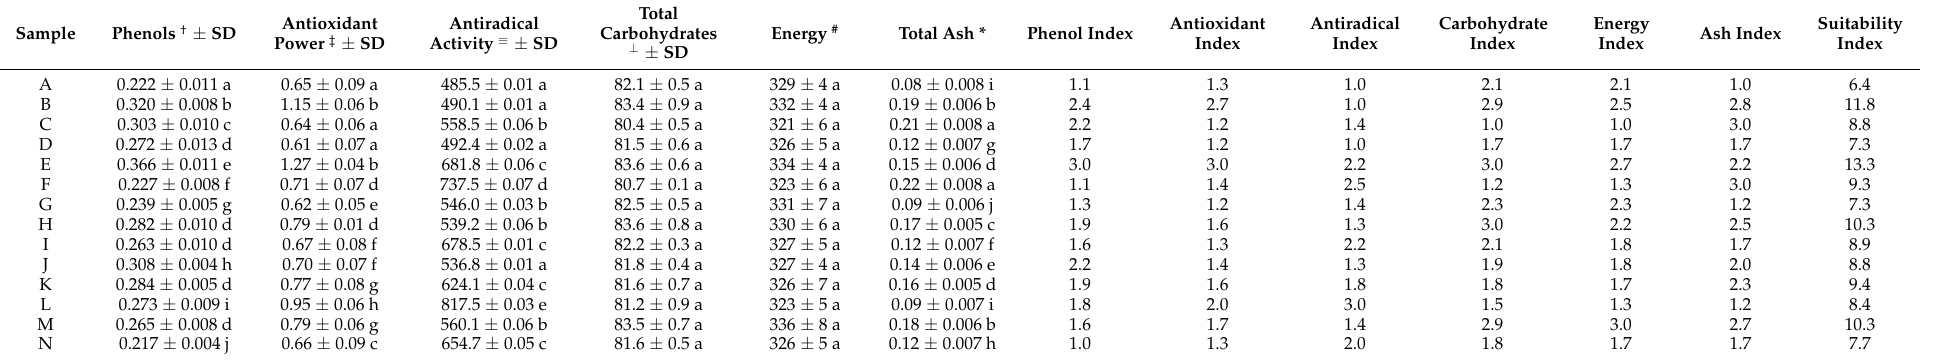
Table 3. Phenol, antioxidant power, and antiradical activity results obtained for honey samples from the Los Lagos Region (Chile).